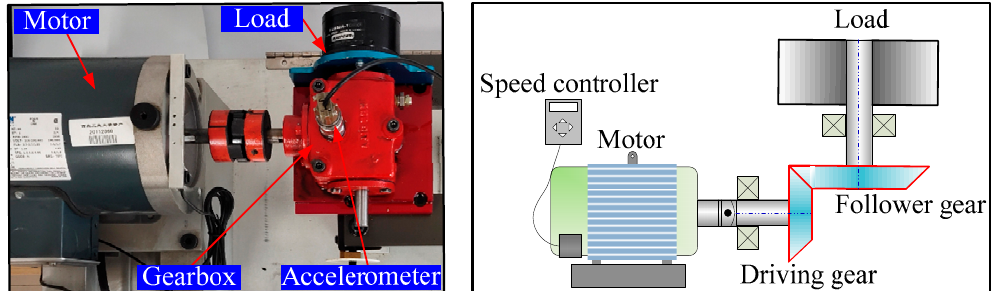
Appl. Sci. 2020 , 10 , x FOR PEER REVIEW 11 of 21 Figure 10. The experimental platform and its schematic diagram. Figure 10. The experimental platform and its schematic diagram.